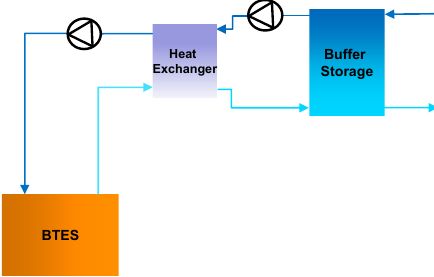
Figure 3. System layout of the passive cooling scenarios (PasSer and PasPar).